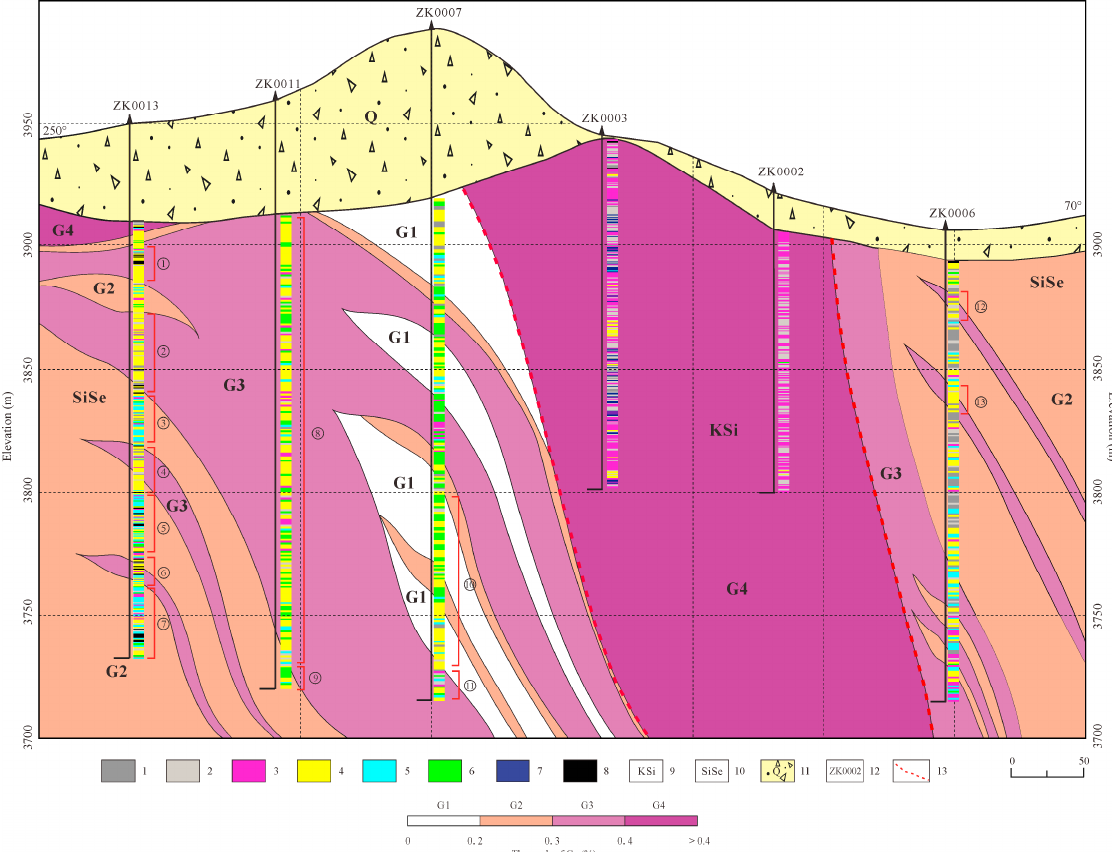
Figure 14. Schematic diagram of the corresponding relationship between the zoning result using the SSAAE and Cu grade in the No. 00 exploration cross-section. 1—Quartz monzonite porphyry; 2—Silification; 3—Potassification; 4—Sericitization; 5—Epidotization; 6—Chloritization; 7—Hornfels; 8—others; 9—potassic-silicified zone; 10—Sericite zone; 11—Quaternary; 12—Drill core and its number; 13—Boundary of alteration zones.